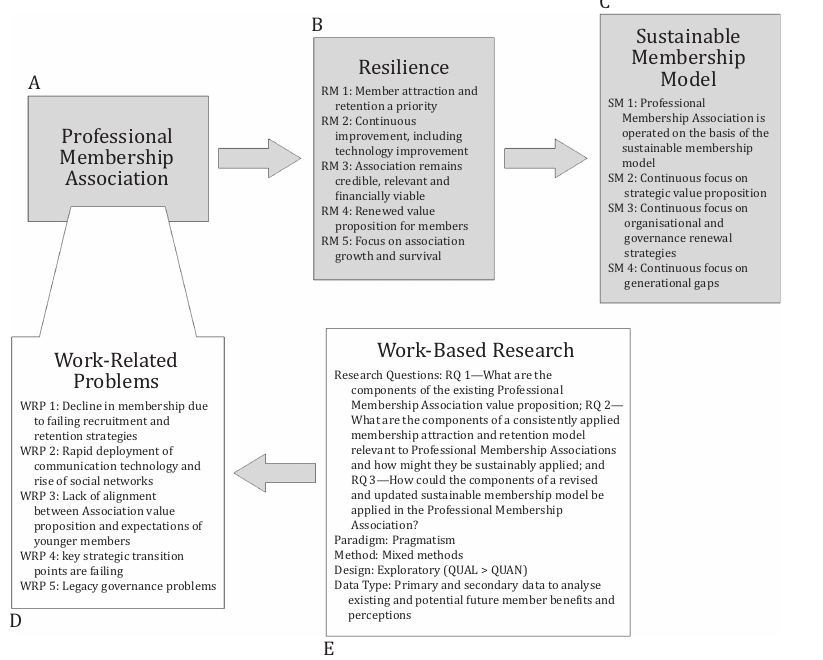
Figure 3. Planning model